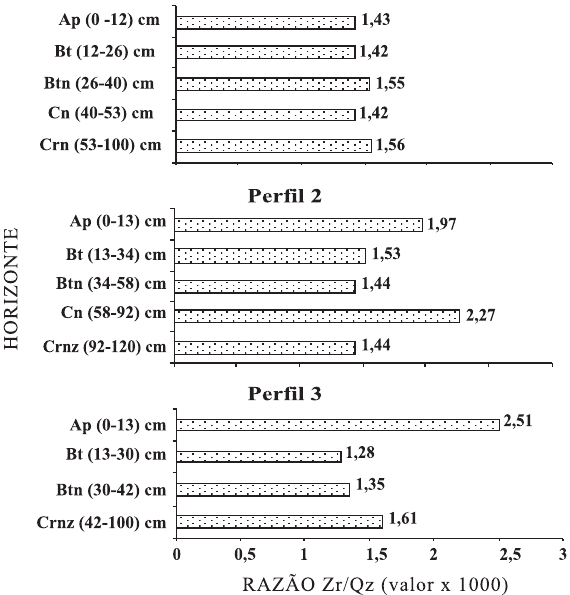
Figura 1. Valores da razão zircônio/quartzo nos